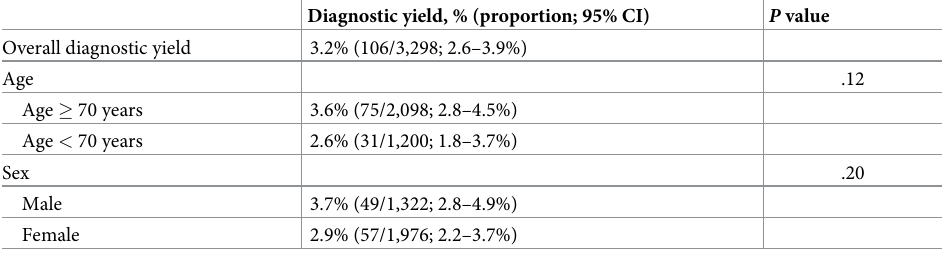
Table 2. Diagnostic yield of diffusion-weighted imaging in patients with cognitive impairment by age groups and sex.